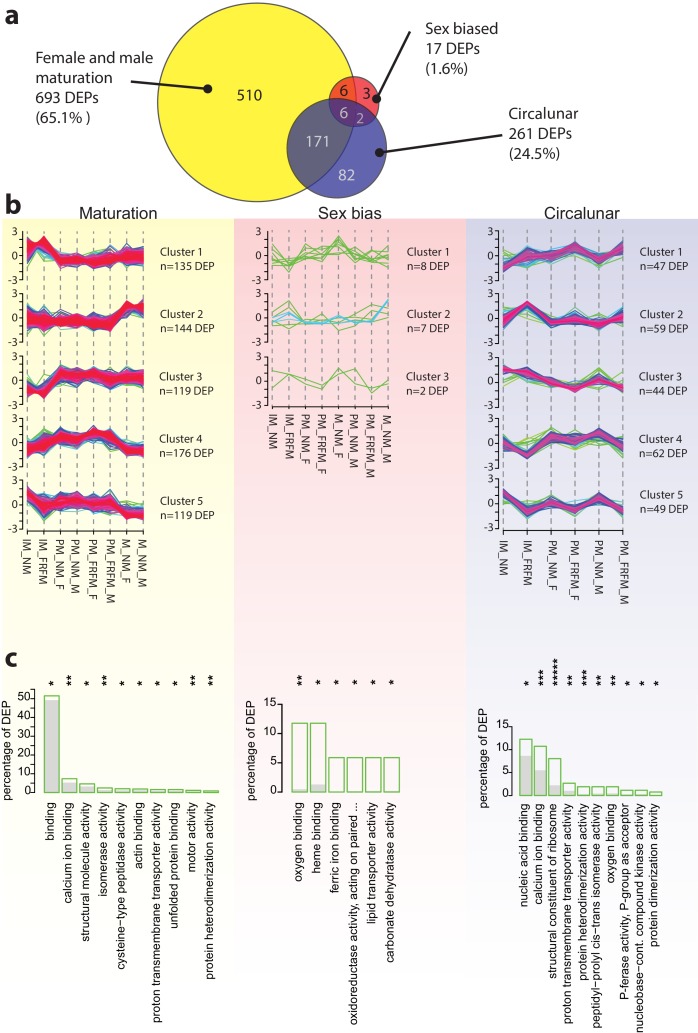
The Platynereis head proteome is differentially affected by maturation, sex and circalunar phase.(a) Venn diagram showing the proteins significantly regulated within and across the three different biological processes in the three major comparisons made (brackets indicate respective fraction of total comparable proteins) (b) Soft clustering of differentially expressed proteins using the Mfuzz algorithm. The expression data for maturation and circalunar phase are best represented by five and for sexually dimorphic protein expression by three clusters. Compare to Figure 3b for similar dynamics in the regulated transcript clusters. (c) GO-term enrichment analysis using the GOStats package on the differentially expressed proteins in each comparison showing the ten most abundant terms in the Molecular Function category (further GO-term analyses: see Figure 5—figure supplement 2–6). Green boxes show the percentage of differentially expressed proteins for each term; the grey bars depict the expected amount of proteins per category. Maturation: binding: GO:0005488, calcium ion binding: GO:0005509, structural molecule activity: GO:0005198, isomerase activity: GO:0016853, cysteine-type peptidase activity: GO:0008234, actin binding: GO:0003779, proton transmembrane transporter activity: GO:0015078, unfolded protein binding: GO:0051082, motor activity, GO:0003774, protein heterodimerization activity, GO:0046982. Sex bias: oxygen binding: GO:0019825, heme binding: GO:0020037, ferric iron binding: GO:0008199, oxidoreductase activity, acting on paired donors, with incorporation or reduction of molecular oxygen, reduced pteridine as one donor, and incorporation of one atom of oxygen (oxidoreductase activity, acting on paired...): GO:0016714, lipid transporter activity: GO:0005319, carbonate dehydratase activity: GO:0004089. Circalunar phase: nucleic acid binding: GO:0003676, calcium ion binding: GO:0005509, structural constituent of ribosome: GO:0003735, proton transmembrane transporter activity: GO:0015078, protein heterodimerization activity: GO:0046982, peptidyl-prolyl cis-trans isomerase activity: GO:0003755, oxygen binding: GO:0019825, phosphotransferase activity, phosphate group as acceptor: GO:0016776, nucleobase-containing compound kinase activity: GO:0019205, protein dimerization activity: GO:0046983. Statistical significance was tested with a hypergeometric test implemented in the GOStats package. *p < 0.05, **p < 0.01, ***p < 0.001, *****p < 0.00001.10.7554/eLife.41556.050Figure 5—source data 1.Labelled proteomics: detected proteins and intensities, filtered and unfiltered.Table contataining protein intensities and calculation of the normalised intensities for both, all 2,290 detected proteins and the BR and TR filtered final list containing 1,064 proteins used for DEP prediction. Used for DEP graphs.10.7554/eLife.41556.051Figure 5—source data 2.Platynereis head reference proteome v4 gene universe.Table containing the "gene universe" for the Prot_v4 used as background for GO-term enrichment analysis in Figs. 5 and S6a-g.10.7554/eLife.41556.052Figure 5—source data 3.Proteome comparison: all over- and under-represented GO-Terms labelled proteomics.Table containing the over-and under-represented GO-terms using all 2,290 proteins deteced in the labelled proteome dataset. GO-terms are shown with their respective p-values, ontology (Molecular Function, Biological Process, Cellular Compartment), and test direction, i.e. over- or under-represented.10.7554/eLife.41556.053Figure 5—source data 4.Proteome comparison: all over- and under-represented GO-Terms unlabelled proteomics.Table containing the over-and under-represented GO-terms using all 3,847 proteins deteced in the unlabelled proteome dataset. GO-terms are shown with their respective p-values, ontology (Molecular Function, Biological Process, Cellular Compartment), and test direction, i.e. over- or under-represented.10.7554/eLife.41556.054Figure 5—source data 5.Proteome comparision: over- and under-represented GO-Terms shared between labelled and unlabelled proteomics.Table containing the over-and under-represented GO-terms shared between the labelled 2,290 proteins and the unlabelled 3,847 proteins sets. GO-terms are shown with p-values, actual counts, expected counts, number of IDs per category for both set, respectively; as well as ontology (Molecular Function, Biological Process, Cellular Compartment).10.7554/eLife.41556.055Figure 5—source data 6.Proteome: ROTS results.This file contains the ROTS predicted DEPs for all 14 comparision made. Each comparison is contained within a separate tab.10.7554/eLife.41556.056Figure 5—source data 7.Proteome: LIMMA results.This file contains the LIMMA predicted DEPs for all 14 comparision made. Each comparison is contained within a separate tab.10.7554/eLife.41556.057Figure 5—source data 8.Proteome: ROTS-LIMMA rank sum files.This file contains the ROTS-LIMMA rank sums for predicted DEPs for all 14 comparision made plus the all maturation rank sum predictions. Each comparison is contained within a separate tab.10.7554/eLife.41556.058Figure 5—source data 9.Proteome: Mfuzz cluster protein IDs with cluster membership values.This file contains the soft clustering output of protein expression values with Mfuzz. Each comparison, maturation, sex, and lunar contains the individual transcript ID and the membership values for each cluster ranging from 0 to 1.10.7554/eLife.41556.059Figure 5—source data 10.Proteome: all over- and under-represented GO-Terms from all comparisions.Table containing the results of the GO-term analysis on transcript level. Individual GO-terms are shown with their respective p-values in each of the three comparisons (maturation, sex, and lunar), as well as their ontolgy, i.e. Molecular Function, Biological Process, or Cellular Compartment.10.7554/eLife.41556.060Figure 5—source data 11.Proteome: over- and under-represented GO-Terms maturation comparison.This file contains the over- and under-representet GO-terms for the maturation comparison on protein level. Tabs for each of the three ontologies, i.e. Molecular Function, Biological Process, and Cellular Compartment.10.7554/eLife.41556.061Figure 5—source data 12.Proteome: over- and under-represented GO-Terms sex bias comparison.This file contains the over- and under-representet GO-terms for the sex comparison on protein level. Tabs for each of the three ontologies, i.e. Molecular Function, Biological Process, and Cellular Compartment.10.7554/eLife.41556.062Figure 5—source data 13.Proteome: over- and under-represented GO-Terms circalunar comparison.This file contains the over- and under-representet GO-terms for the lunar comparison on protein level. Tabs for each of the three ontologies, i.e. Molecular Function, Biological Process, and Cellular Compartment.10.7554/eLife.41556.063Figure 5—source data 14.Lunar proteome repetion: detected proteins and intensities, filtered and unfiltered.Table contataining protein intensities and calculation of the normalised intensities for both, all 2,092 detected proteins and the BR and TR filtered final list containing 1,671 proteins used for DEP prediction from the lunar proteome repetion experiment.10.7554/eLife.41556.064Figure 5—source data 15.Lunar proteome repetion: ROTS-LIMMA significant proteins.This file contains the ROTS-LIMMA rank sums for predicted DEPs for the repeat lunar proteome experiment using only IM sample, containg the 1,671 filtered and analysed proteins.10.7554/eLife.41556.065Figure 5—source data 16.Lunar proteome set1-set2 ovelapping IDs ROTS-LIMMA significant proteins in set1.This file contains the ROTS-LIMMA rank sums of DEPs predicted as significant in the first proteomics experiment (set1); using only the 1,017 proteins detected in both, the first (set1) and the second experiment (set2) as input data.10.7554/eLife.41556.066Figure 5—source data 17.Lunar proteome set1-set2 ovelapping IDs ROTS-LIMMA significant proteins in set2.This file contains the ROTS-LIMMA rank sums of DEPs predicted as significant in the second proteomics experiment (set2); using only the 1,017 proteins detected in both, the first (set1) and the second experiment (set2) as input data.10.7554/eLife.41556.067Figure 5—source data 18.Lunar proteome: all ROTS-LIMMA significant proteins with BLASTx annotation.This file contains all DEPs predicted as significantly circalunar different by either the first, the second, or both proteome experiments. All proteins have also a BLASTx annotions where possible. Positive identification is marked by '+' in the respective column.10.7554/eLife.41556.068Figure 5—source data 19.All proteins significantly regulated during maturation (maturation DEPs).This file contains the IDs, mean expression values, top hit by blastX with e-value cut-off 10-4, e-value corresponding to blast hit, number of identical/ similar AA or gaps in blast alignment ("identity", "positives", "gaps") for all proteins significantly regulated during maturation.10.7554/eLife.41556.069Figure 5—source data 20.All proteins significantly regulated during sexual differentiation (sex DEPs).This file contains the IDs, mean expression values, top hit by blastX with e-value cut-off 10-4, e-value corresponding to blast hit, number of identical/ similar AA or gaps in blast alignment ("identity", "positives", "gaps") for all proteins significantly regulated between males and females.10.7554/eLife.41556.070Figure 5—source data 21.All proteins significantly regulated between circalunar phases (lunar DEPs).This file contains the IDs, mean expression values, top hit by blastX with e-value cut-off 10-4, e-value corresponding to blast hit, number of identical/ similar AA or gaps in blast alignment ("identity", "positives", "gaps") for all proteins significantly regulated between circalunar phases.